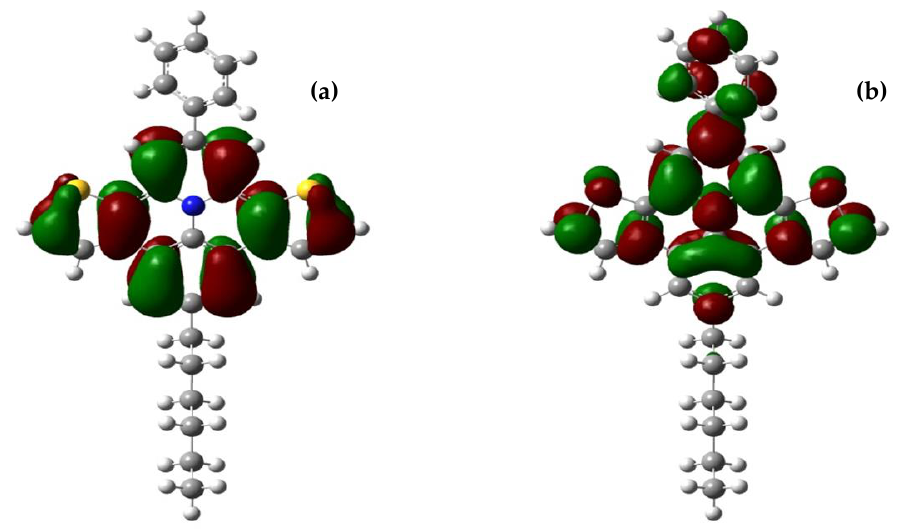
Figure 7. HOMO ( a ) and LUMO ( b ) densities of the 4a cation in methanol, calculated using the B3LYP/6-31G(d) method and the PCM option.